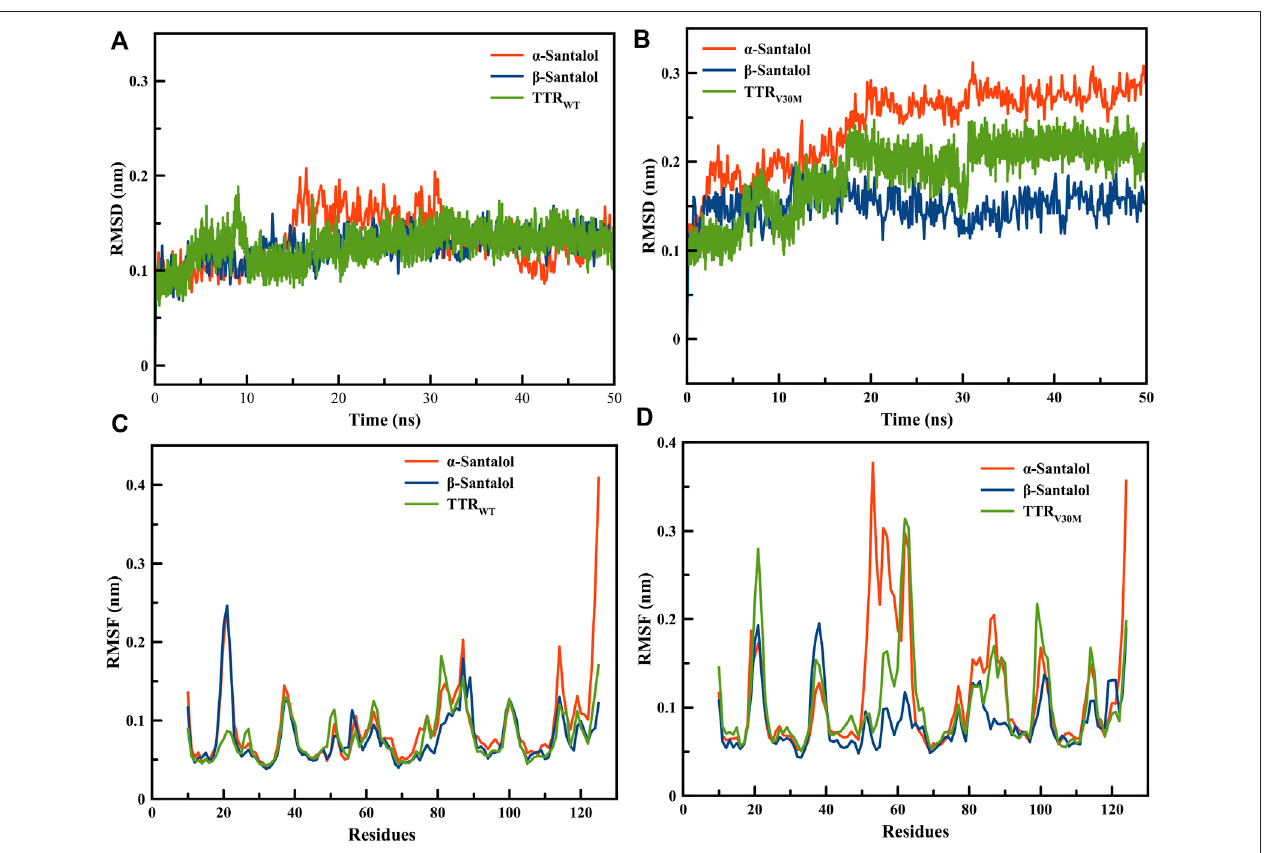
FIGURE 2 | Root mean square deviations for backbone atomic position of (A) TTR WT and (B) TTR V30M in complex with santalol isomers throughout 50 ns MD simulations. Root mean square fl uctuation during the MD simulation run for the critical amino acids of (C) TTR WT and (D) TTR V30M in complex with santalol isomers.